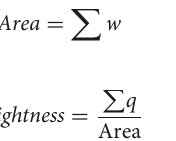
images to ExG images according to the formula ( Figure 4D ). (5) Binary option with the ExG images. The results were binary images ( Figure 4F ). (6) Extract green channel images from the RGB images of step (3) ( Figure 4E ). (7) Mask the binary images ( Figure 4F ) to green channel images ( Figure 4E ). The results were the green channel images of the binary area ( Figure 4G ). (8) Calculate the parameters related to area, brightness, and change trend according to the images of Figure 4G